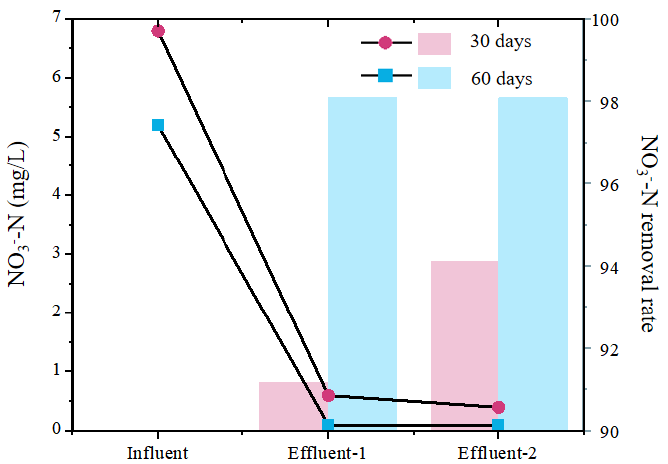
Figure 2. The nitrogen removal performance of the MBfRs with operation times of 30 days and 60 days.